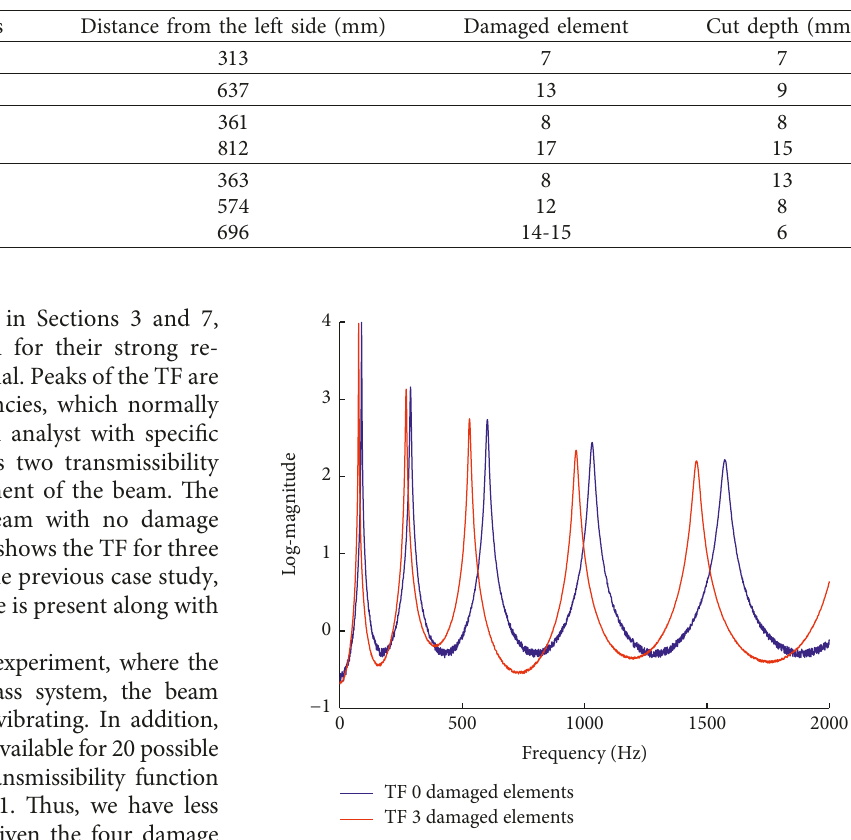
Figure 17: Transmissibility functions measured for the tenth el- ement of the structural beam. Blue line corresponds to the no damage scenario, whereas in orange, the system has three randomly damaged